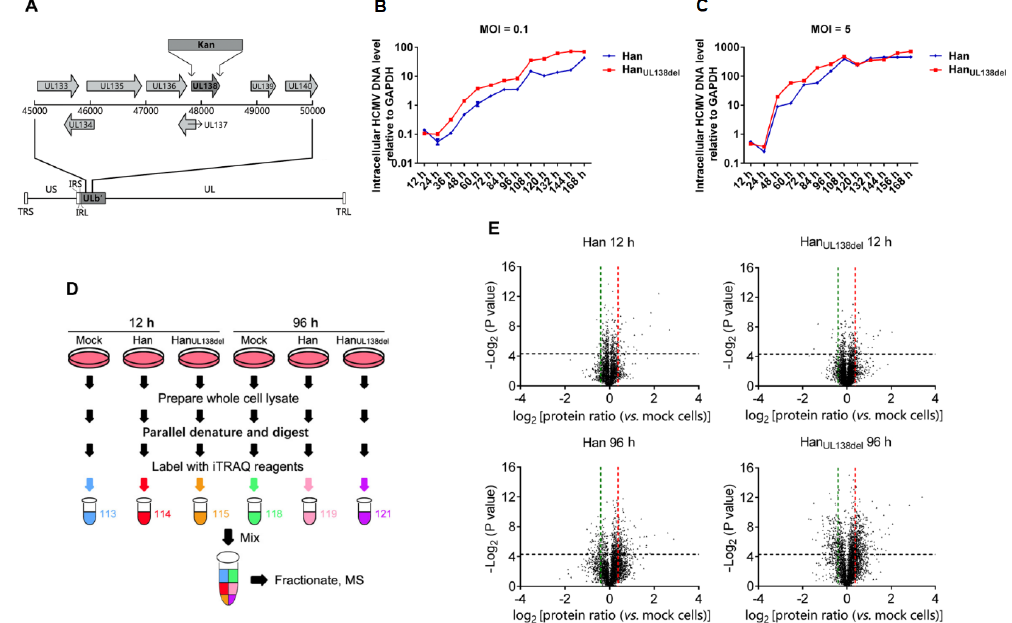
Figure 1. Comparative quantitative proteomic analysis of Han- and Han UL138del -infected MRC5 cells. ( A ) Construction of Han UL138del -BAC. The ORF of UL138 in the ULb’ region was replaced by the kanamycin resistance cassette. ( B ) Replication kinetics curves of Han and Han UL138del in MRC5 cells infected at an MOI of 0.1. Cells were harvested separately every 12 h for 7 days post